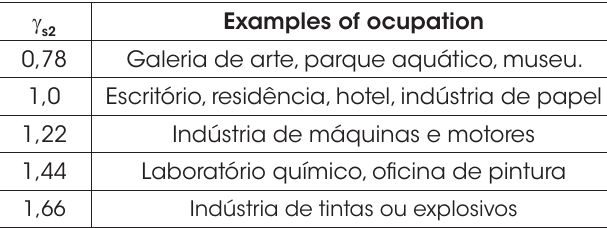
in function of the risk of Values of γ s2